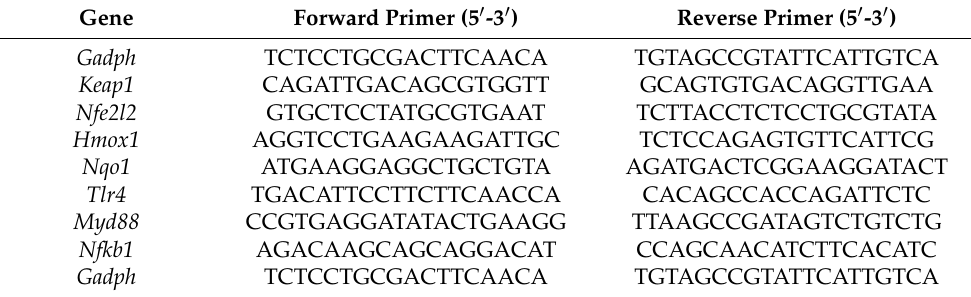
Table 1. Primer sequences of genes used for qRT-PCR.